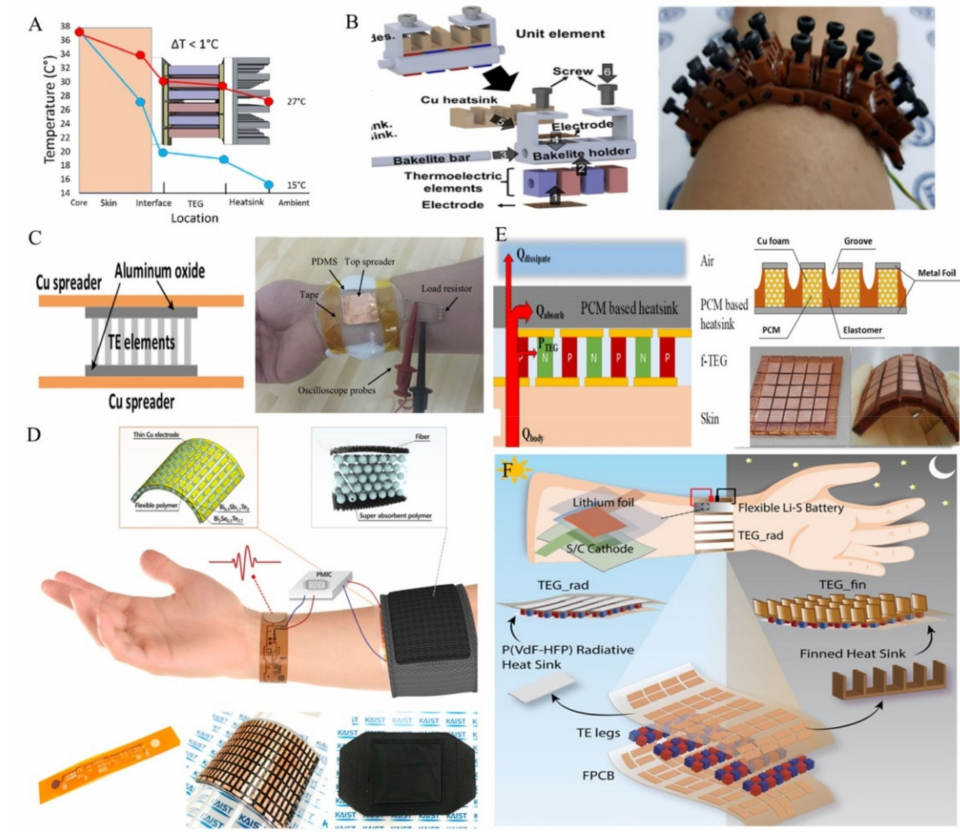
Figure 8. ( A ) Temperature difference from core body temperature to the ambient air [44]. ( B ) Schematic structure of FTEG with a copper heat sink and the fabricated device worn on the wrist [67]. ( C ) Schematic of the r-WTEG with a heat spreader and the experimental setup of the TEG on the wrist [54]. ( D ) Schematic of the FTEG with a flexible heat sink base on SAP [71] ( E ) with a flexible PCM heat sink [74] and ( F ) with a radiative cooling heat sink